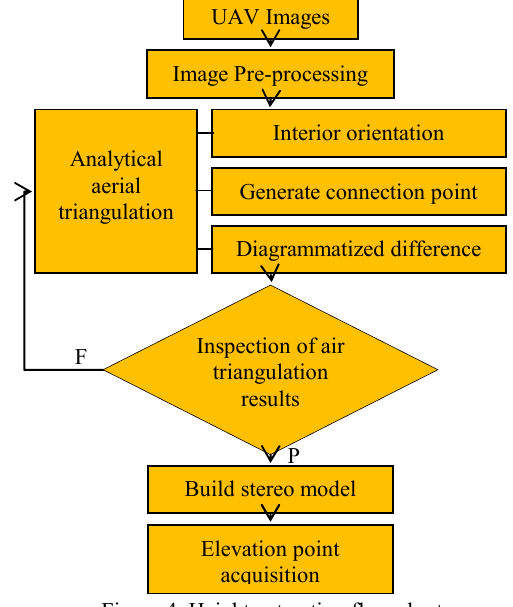
Figure 4. Height extraction flow chart